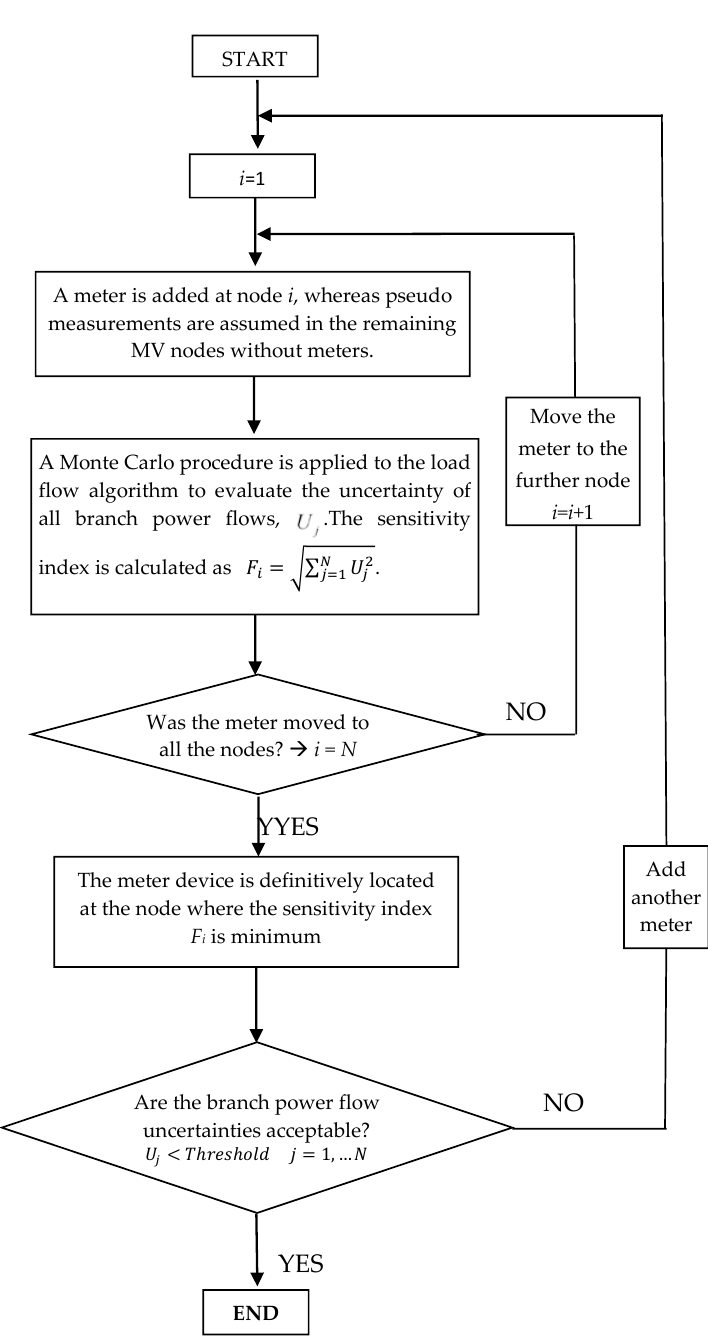
Figure 3. Flowchart of the proposed incremental placement Figure 3 . Flowchart of the proposed incremental placement algorithm.